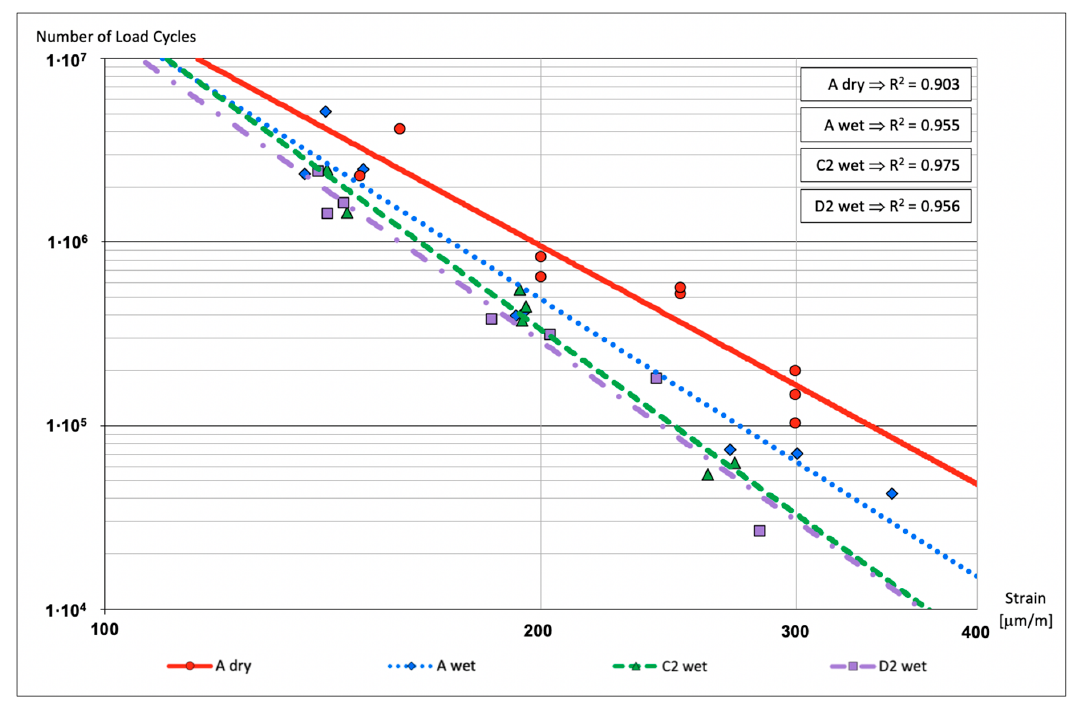
Figure 5. Fatigue test. Figure 5. Fatigue Table 5. Goodness-of-fit statistic. Log (cid:2869)(cid:2868) (Number of load cycles) - Log (cid:2869)(cid:2868) (Strain). Fatigue.